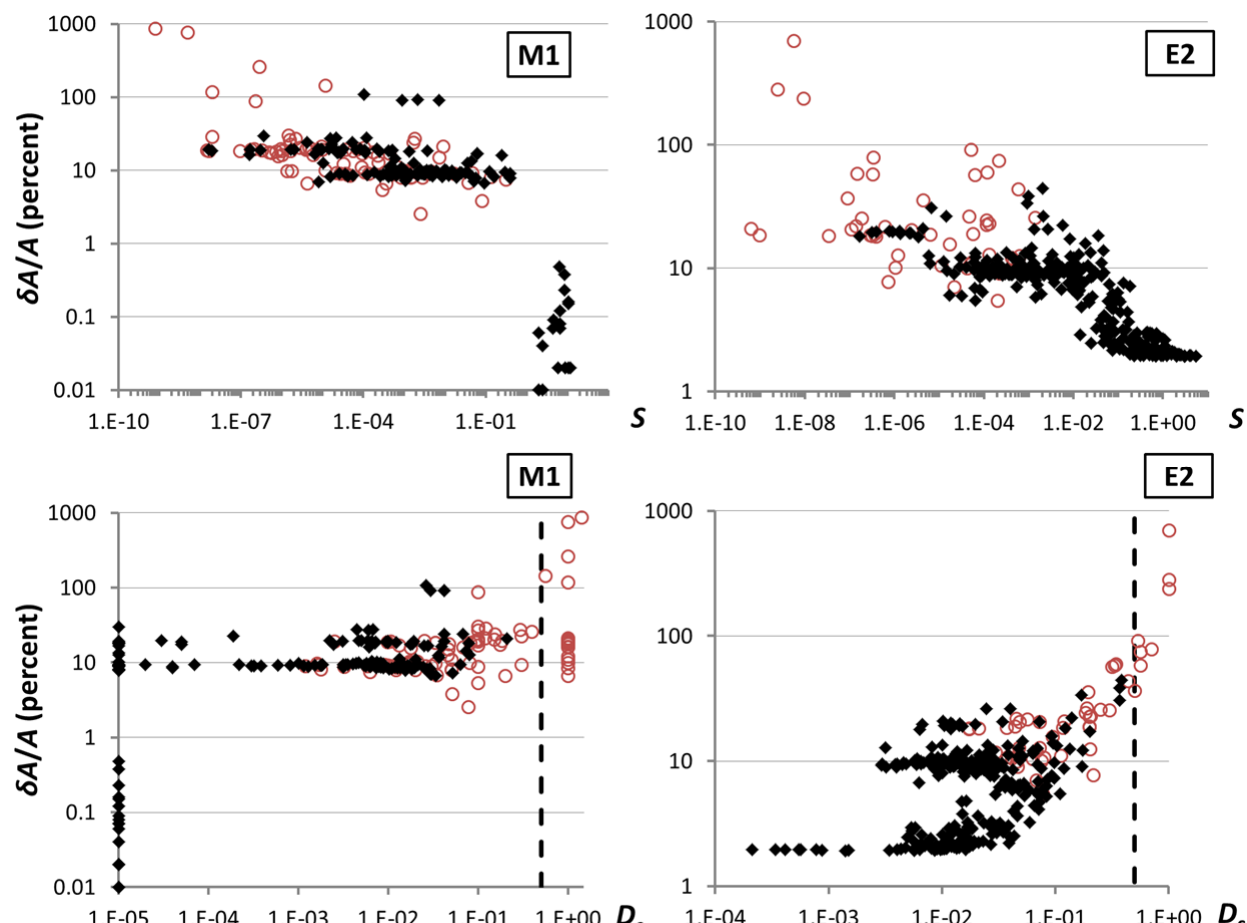
Figure 1. Relative s tandard deviations δ A / A (percent) of Monte Carlo trial data for M1 ( left ) and E2 ( right ) transitions of Fe V versus line strength S ( top ) and versus degree of cancellation D = δ /|CF| ( bottom ). Full symbols—transitions with weak cancellation, c CF |CF| ≥ 0.01; open symbols—transitions with strong cancellation, |CF| < 0.01. Vertical dashed lines in the bottom part show the boundary between regions of significant and insignificant cancellation, D > 0.5 and D < 0.5, c c